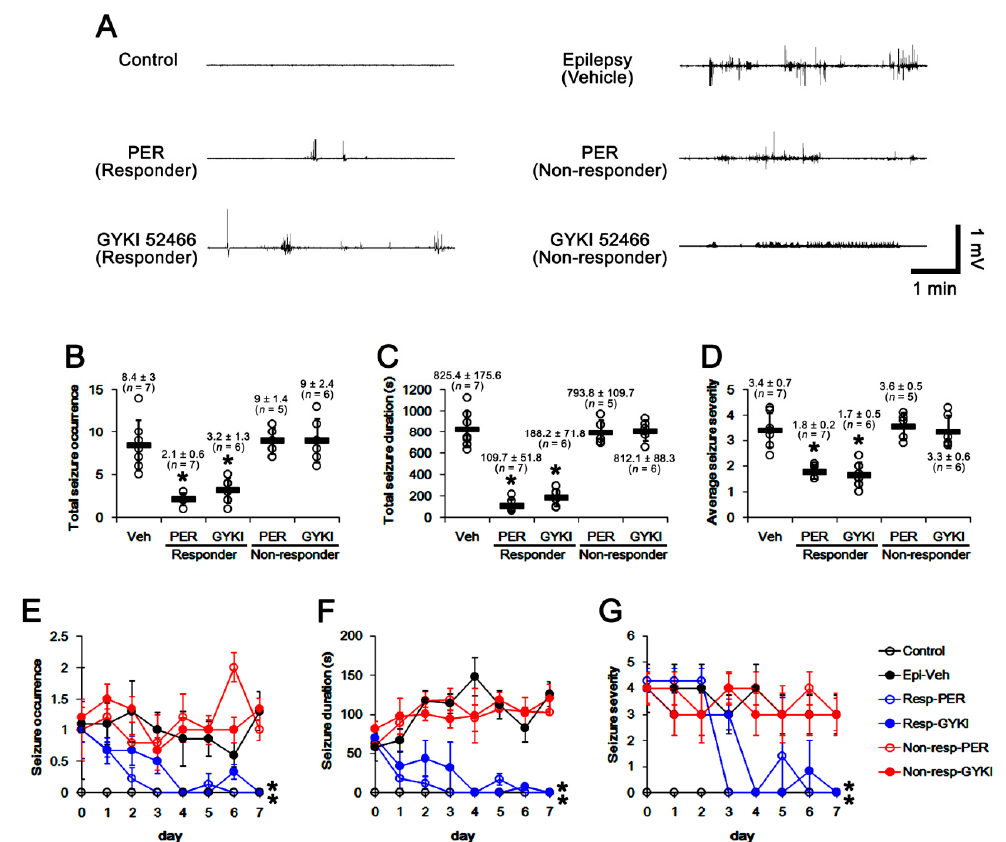
Figure 1. The e ff ects of perampanel (PER) and GYKI 52,466 (GYKI) on spontaneous seizure activities in chronic epilepsy rats. Both α -amino-3-hydroxy-5-methylisoxazole-4-propionic acid receptor (AMPAR) antagonists e ff ectively attenuate spontaneous seizure activities in responders. ( A ) representative electroencephalograms (EEG) in each group at two days after treatment. ( B – D ) Quantitative analyses of total seizure occurrence ( B ), total seizure duration ( C ) and average behavioral seizure score (seizure severity, D) in a seven-day period. Open circles indicate each individual value. Horizontal bars indicate mean value. Error bars indicate SD ( * p < 0.05 vs. vehicle (Veh)-treated animals; Mann Whitney U-test for total seizure occurrence and average seizure severity; Student t -test for total seizure duration). ( E – G ) Quantitative analyses of the chronological e ff ects of AMPAR antagonists on seizure occurrence ( E ), seizure duration ( F ), and seizure severity ( G ) over a seven-day period. Error bars indicate SD ( * p < 0.05 vs. vehicle (Veh)-treated animals; Friedman test for seizure occurrence and seizure severity; repeated measures ANOVA for seizure duration).